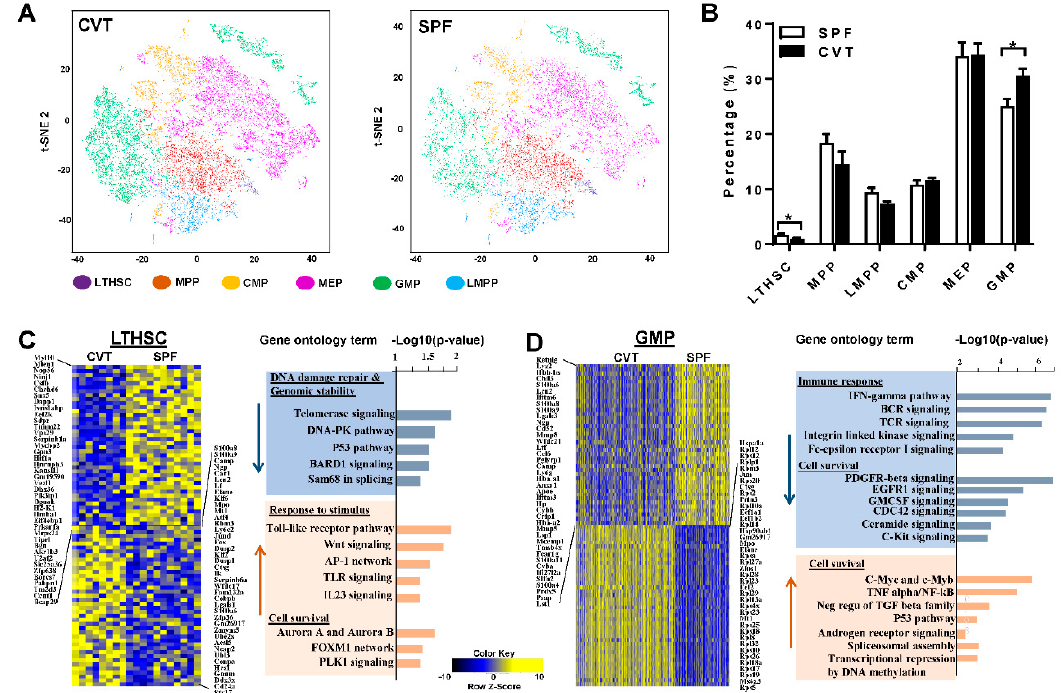
Figure 3. ( A ) BM cells from CVT (n = 8) and SPF (n = 8) mice at one month of co-housing were sorted to collect KL (Kit + Lin − ) cells, pooled to form 4 KL cell pools for each housing condition, and then analyzed by single-cell RNA-seq. t-distributed stochastic neighbor embedding (tSNE) plot revealing KL single-cell gene expression in various hematopoietic stem and progenitor cell (HSPC) subsets in CVT and SPF mice: LTHSC, long-term hematopoietic stem cells; MPP, Multipotent progenitors; CMP, common myeloid progenitors; MEP, megakaryocytic-erythroid progenitors; GMP, granulocyte-monocyte progenitors; LMPP, lymphoid-primed multipotent progenitors. ( B ) Percentages of HSPC subsets in KL cells from CVT and SPF mice. ( C ) Gene expression heatmap and pathway analyses for LTHSCs showing up- and down-regulation of genes in CVT relative to SPF mice. ( D ) Gene expression heatmap and pathway analyses for GMPs showing up- and down-regulation of genes in CVT relative to SPF mice. * p < 0.05. Gene expression in KL, LTHSC and GMP cells showed 161, 240 and 2152 genes up-regulated